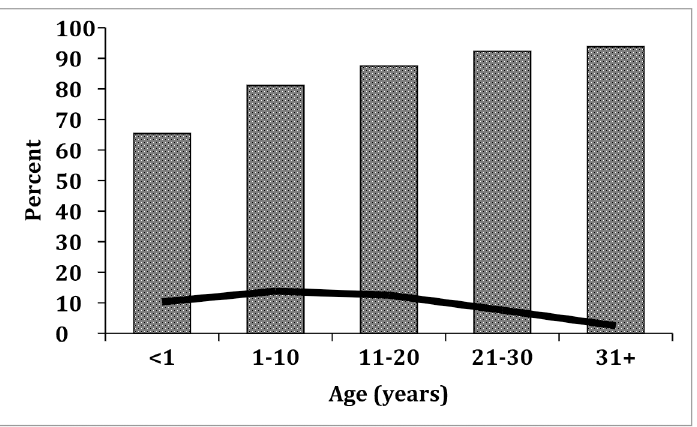
Fig 3. Dengue seroprevalence in PNG. Columns represent age groups, and the proportion of NAb-positive sera is shown for each group. Seroprevalence increases with age, plateauing after adults reach 20 years of age. Monotypic infections (black line) decline to close to zero with increasing